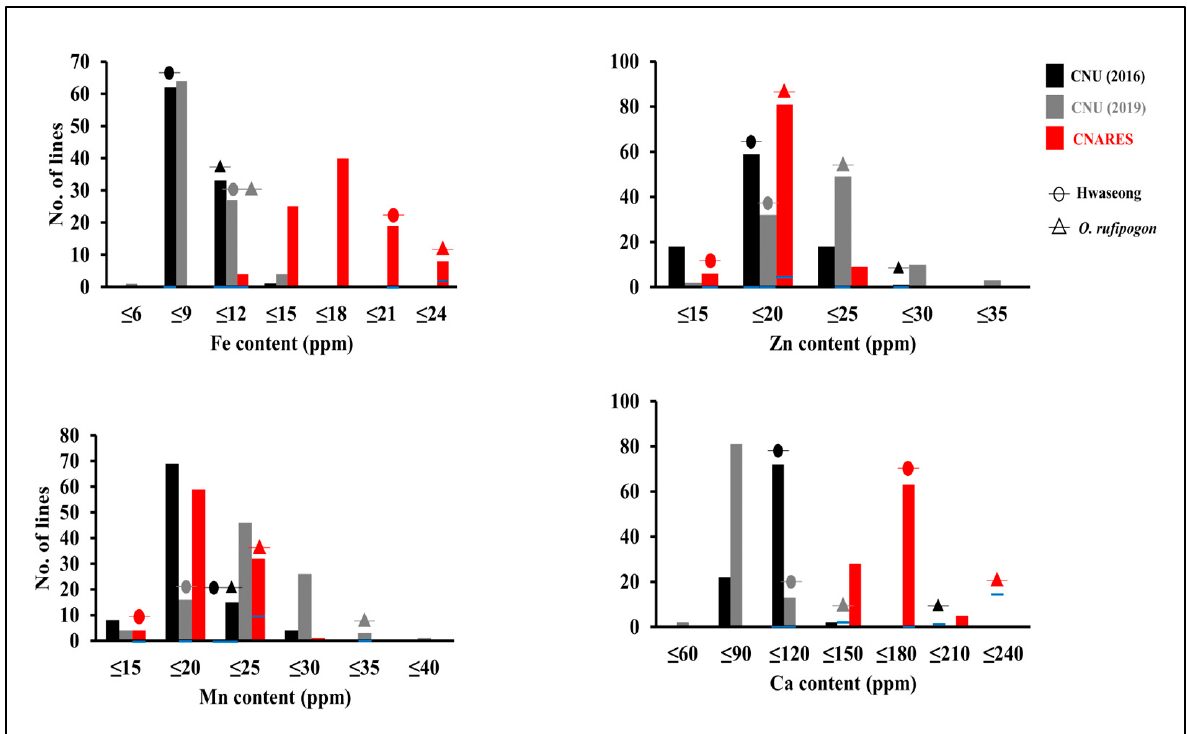
Figure 1. Frequency distribution of mineral element contents in brown rice in 96 ILs and parental lines. Values of Hwaseong and O. rufipogon represent mean ± standard deviation (horizontal bar line) of triplicate (CNU) and duplicate (CNARES)